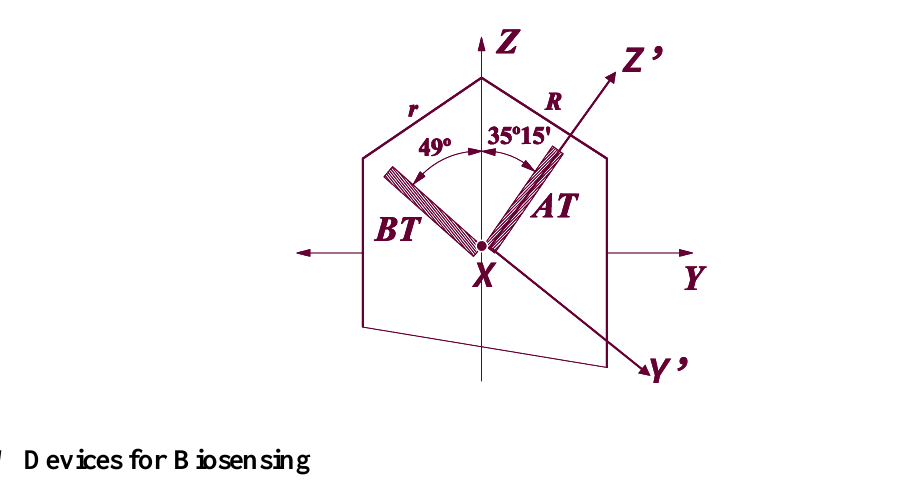
Figure 11. Y’-cuts of a quartz crystal (AT cut is 35°15’ rotated about the X- axis and BT cut is 49° rotated about the X-